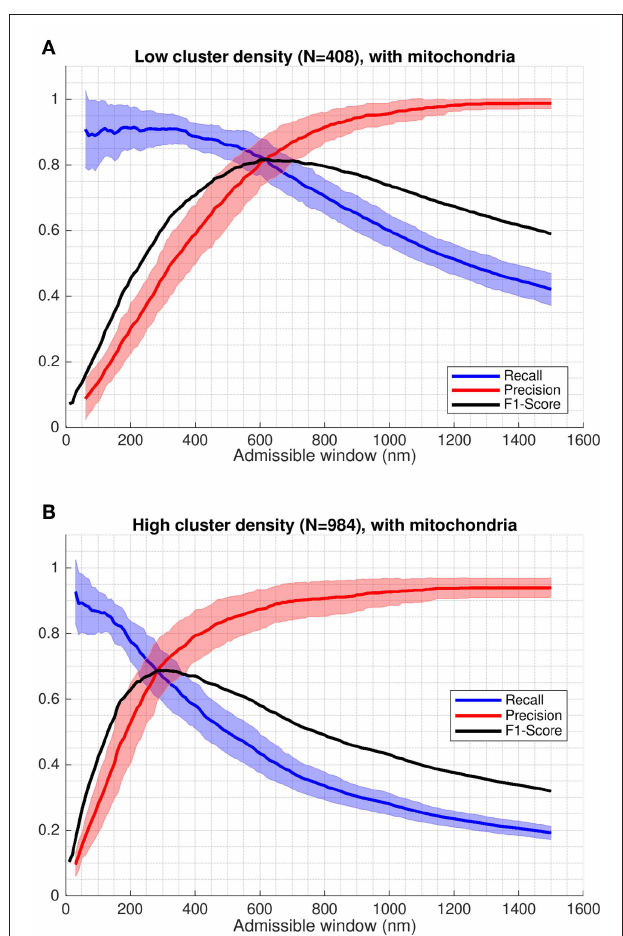
FIGURE 5 | Recall and precision of CaCLEAN applied to simulated microscopy data. Recall, precision and f1-score evaluated based on classification results. Shaded regions indicate one standard deviation of recall and precision values. The f1-score shown is evaluated based on the mean values for precision and recall (solid red and blue lines). In both cases shown, regions representing mitochondria act as barriers to diffusion. (A) A minimum spacing of 1 µ m is enforced between modeled clusters of RyRs. (B) Cluster spacing is determined by statistical analysis of RyR cluster distributions from immuno-labeled super-resolution microscopy data.